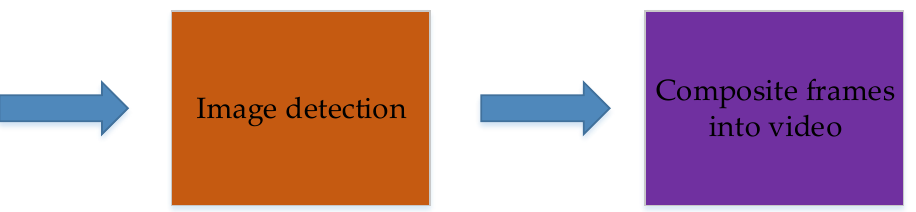
Figure 10. The universal work flow of the two-stage video object detection. The framework is based on the two-stage image object detection, which is the “Image detection” module in the figure.